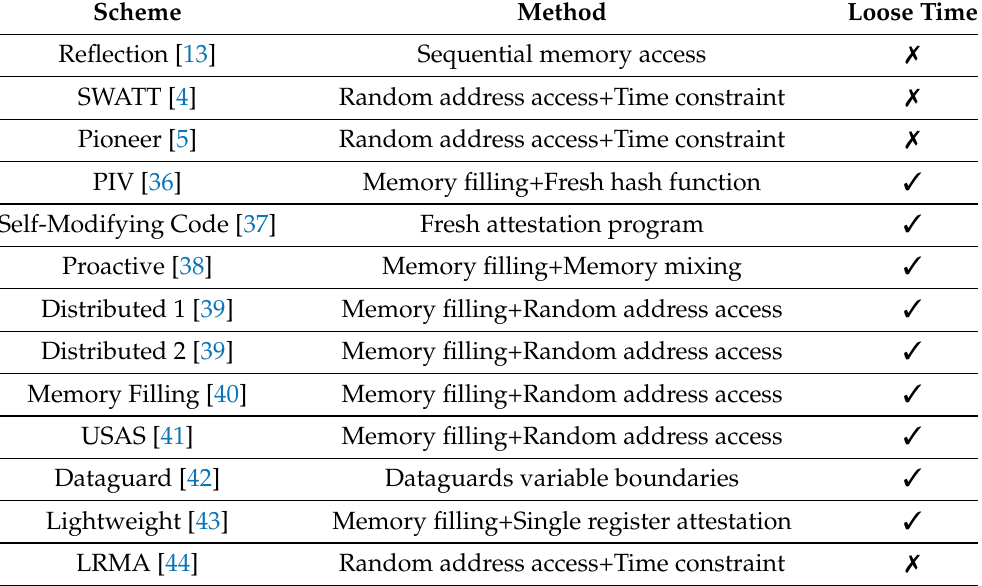
Table 2. Overview of software-based RA